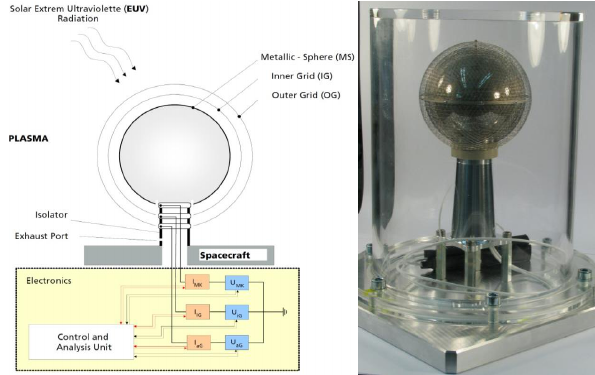
Figure 35. The SEPS sensor consists of three isolated spheres/electrodes connected to sensitive floating electrometers and voltage sources, each. By setting different potentials to the electrodes, measurements of the ambient plasma parameters and of the extreme ultraviolet (EUV) radiation are performed. In this way several measurement modes, such as the following, are possible: Langmuir, plasma shielded Langmuir, RPA (random-phase approx- imation) electron, RPA ion, EUV radiation and EUV Occultation modes. The metallic surfaces involved are minimizing degradation in the EUV spectral